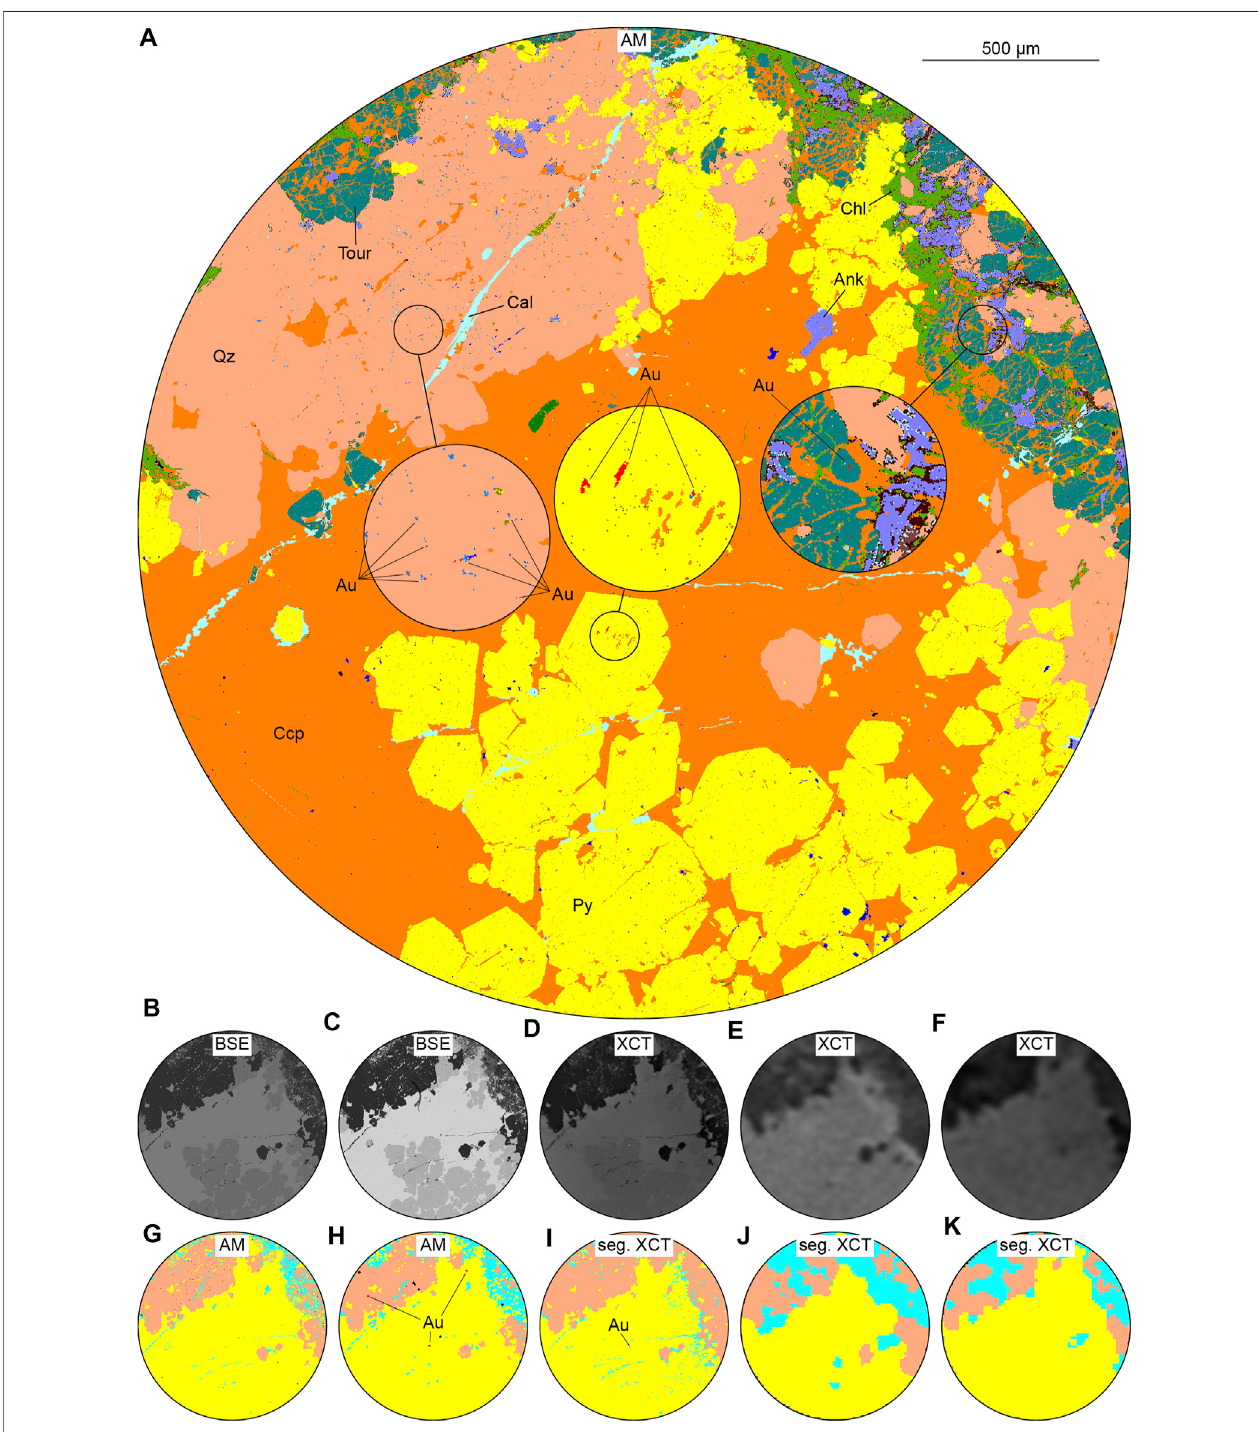
FIGURE 6 | AM and XCT images of a region of interest in the polished rock chip of sample 2. For color coding of the minerals, see Table 2 . (A) 1 μ m pixel size AM mineral map. The circles show enlarged images of the small circles. Gold inclusions are found in a number of minerals but are very fi ne-grained. The marked grains representonlyaportionoftheAugrainsdetected inthemap. (B) 1.87 μ mpixelsizeAMBSEimage. (C) 250 nmpixelsizeAMBSEimage. (D) 4 μ mvoxelsizeXCTscan. (E) 30 μ m voxel size XCT scan. (F) 45 μ m voxel size XCT scan. (G) 1 μ m pixel size simpli fi ed AM mineral map. The same gold grains as in (A) are detected but not visible in the map due to the small size of the image. (H) 30 μ m pixel size simpli fi ed AM mineral map. Three Au grains are detected. (I) 4 μ m voxel size segmented XCT scan.OneAugrainisdetected. (J) 30 μ mvoxelsizesegmentedXCTscan. (K) 45 μ mvoxelsizesegmentedXCTscan.Thelossindetailbetweenthe4 μ mXCTscan (D, I) and the 30 μ m (E, J) and 45 μ m (F, K) XCT scans is apparent. Abbreviations: Ank – ankerite, Cal – calcite, Ccp – chalcopyrite, Chl – chlorite, Py – pyrite, Tour – tourmaline, Qz – quartz.